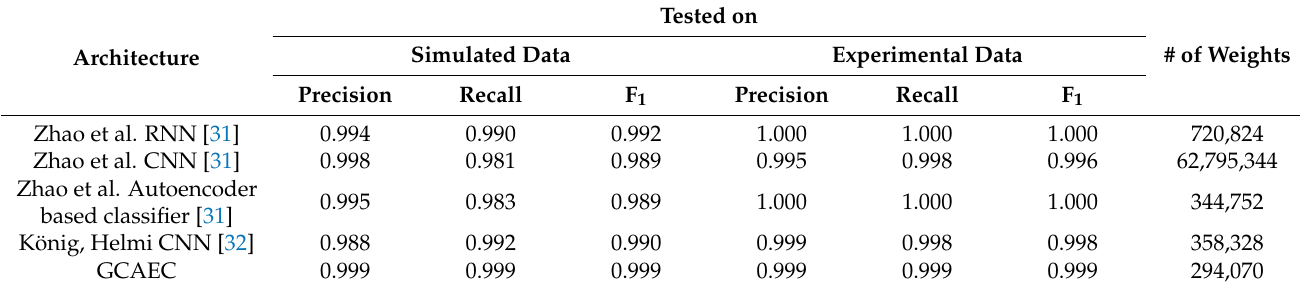
Table 5. Performance metrics for the classification of 4 system states by reference NN architectures. Models are trained with 10-s windows sampled from a mixed